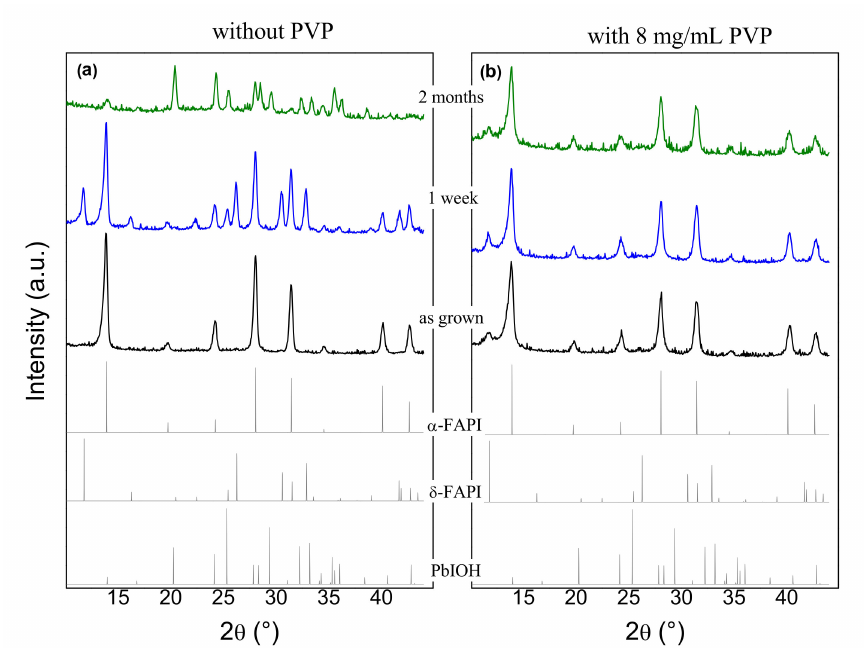
Figure 2. Time dependence XRD patterns of thin films on a glass substrate: ( a ) pure FAPI film, ( b ) FAPI film containing 8 mg/mL